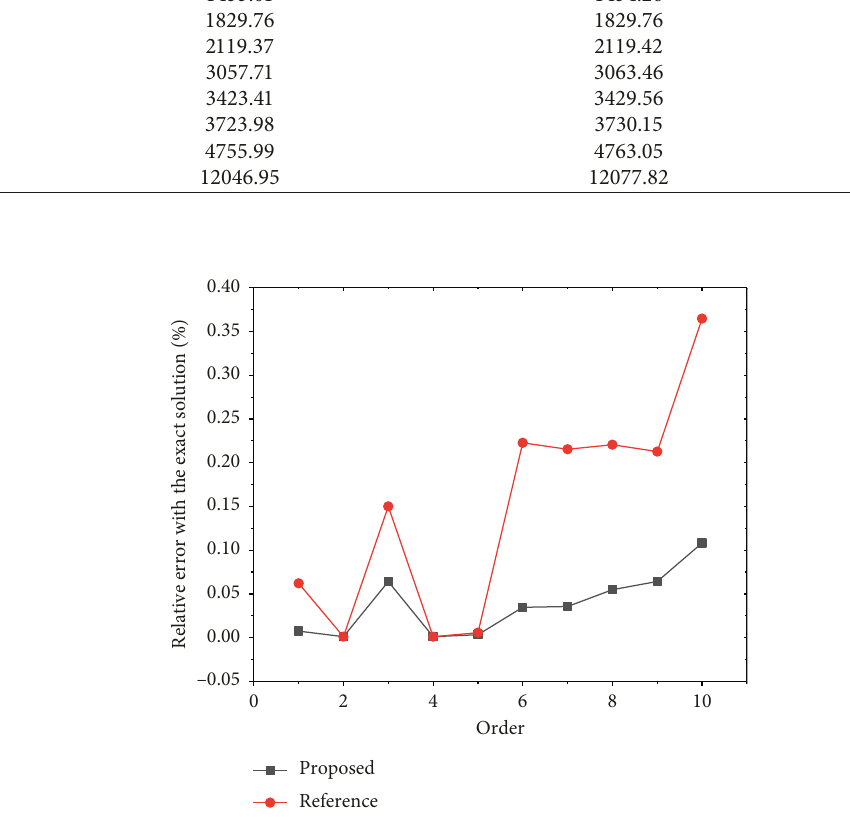
Figure 6: Comparison diagram of relative error between numerical solution and exact solution.